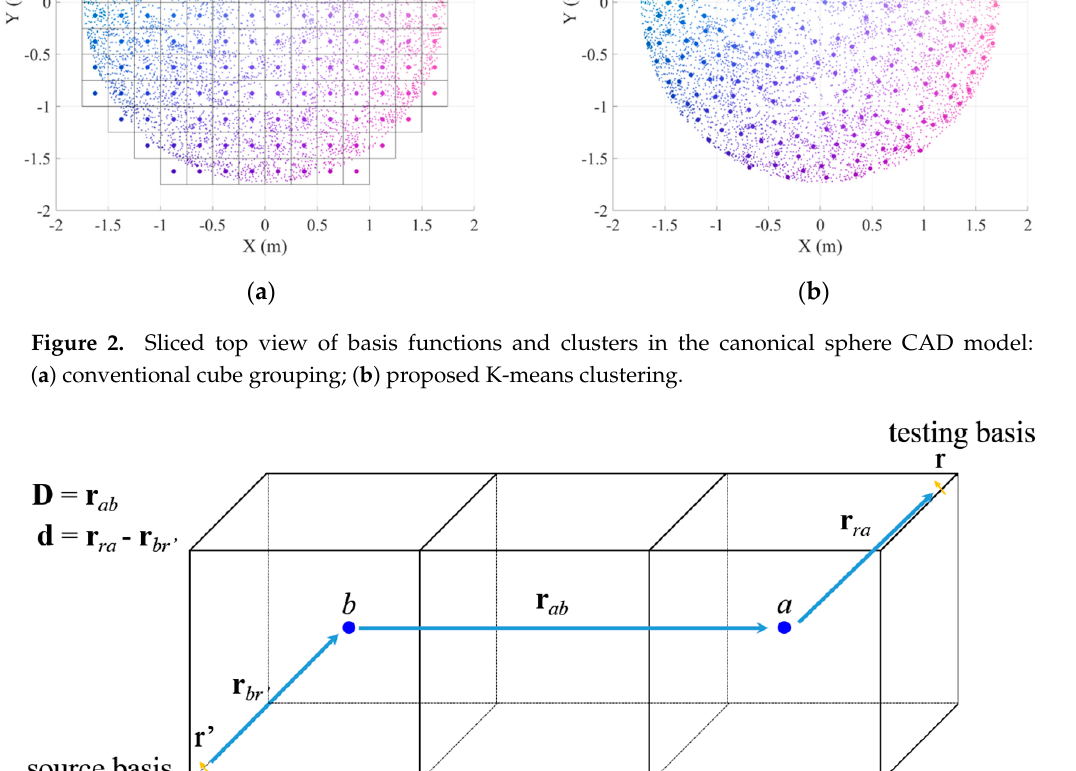
the lowest level is calculated by using the receive